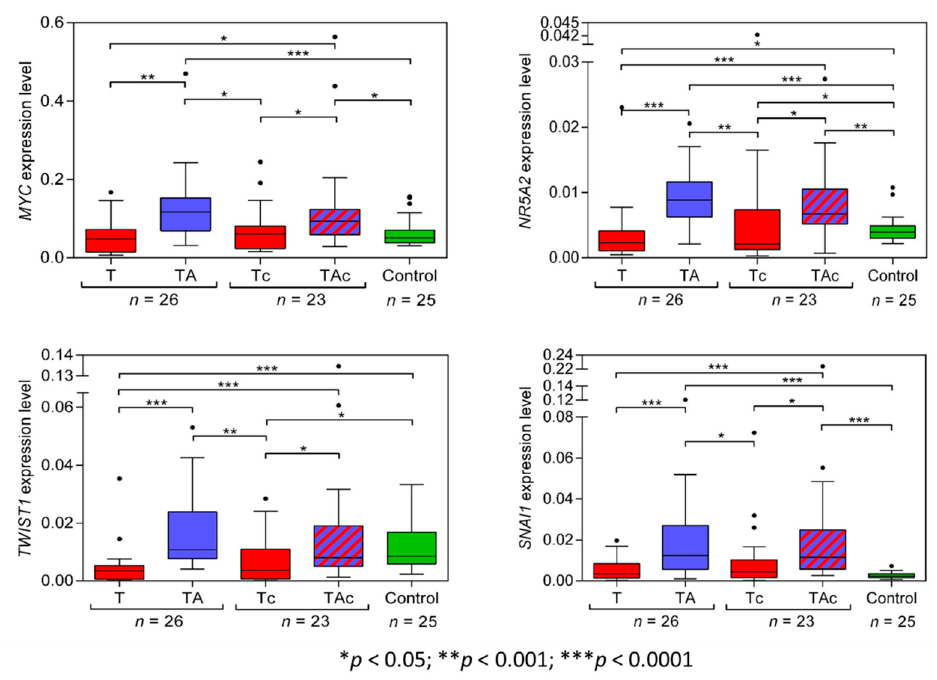
Figure 2. MYC , NR5A2 , TWIST1 , and SNAI1 expression levels in tumors (T, red) and tumor-adjacent tissues without (TA, blue) or with (TAc, blue-dashed) cancer cell content in patients with EC, and in endometrial tissue in cancer-free patients with leiomyoma (Control, green).